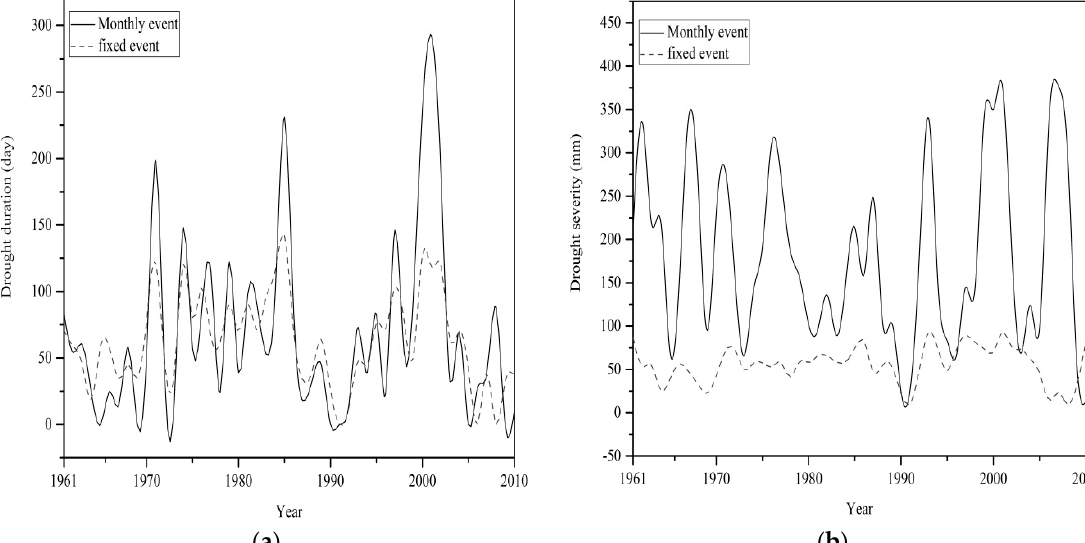
Water 2019 , 11 , 1454 Figure 23. Annual duration and average severities of Zone I. ( a ) Drought duration ( b ) Drought Figure23. AnnualdurationandaverageseveritiesofZoneI.( a )Droughtduration( b )DroughtSeverities.